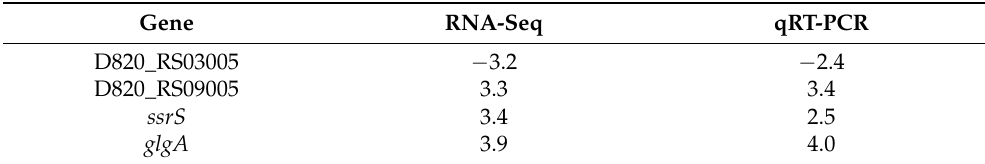
Table 5. Validation of differentially expressed genes using qRT-PCR. Transcript levels of selected genes (Table 1) were corrected to gyrB . Each value (log 2 fold change) is the median of five replicate PCR